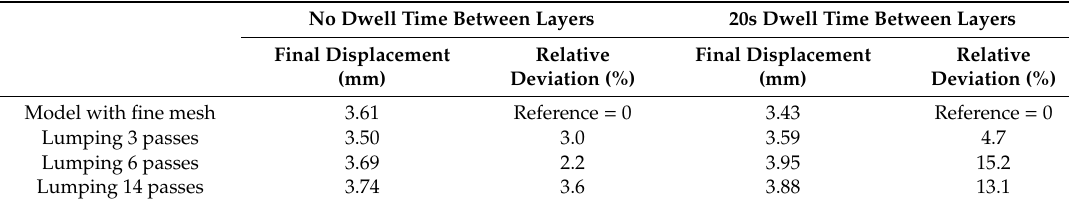
Figure 12. The computed displacements for the model with fine mesh compared with those with lumping of 3, 6, and 14 passes. The models with no dwell time between layers are shown in ( a ), ( c ) and ( e ) whereas ( b ), ( d ) and ( f ) show the same results for the cases with 20 s dwell time. Table 6. Final displacement and relative deviation for all